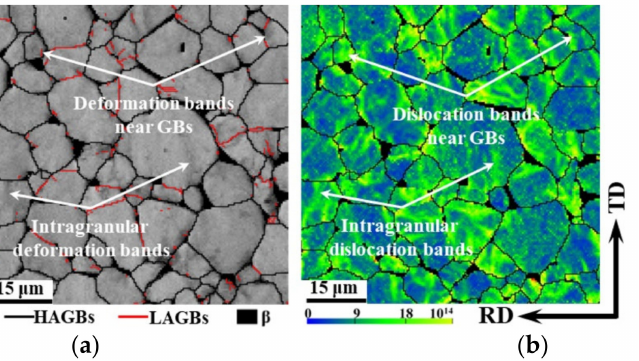
Figure 7. Image quality (IQ) map and GNDs density map of the TA15 tensile samples (750 ◦ C–0.01 s − 1 – true strain 0.1). ( a ) IQ; ( b ) GNDs density.